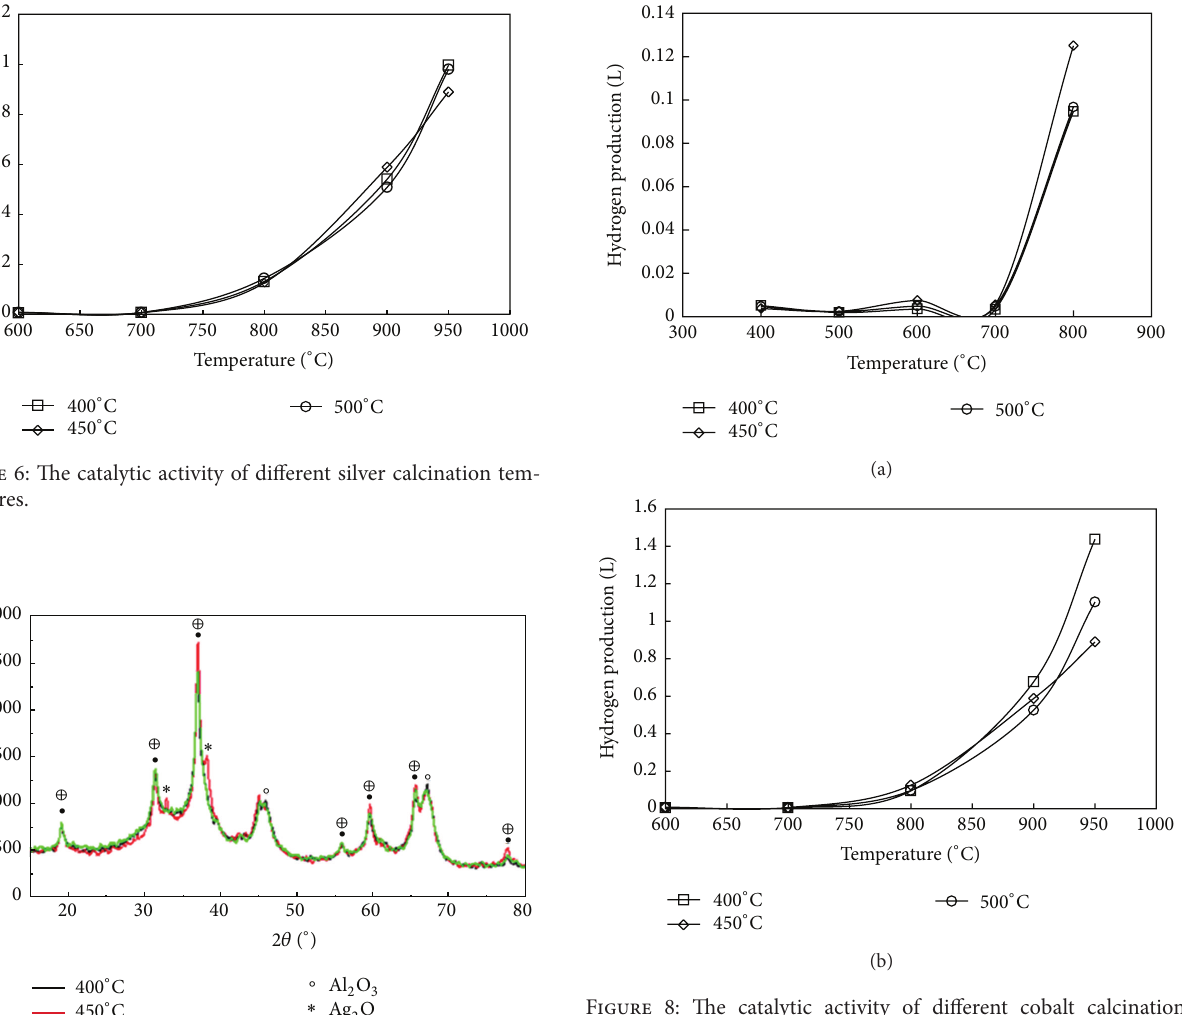
Figure 8: The catalytic activity of different cobalt calcination